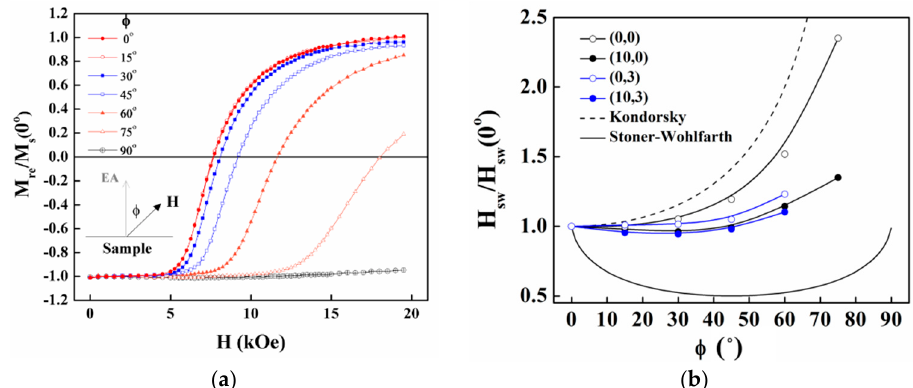
Figure 7. ( a ) A series of room temperature normalized ( M re / M s ) easy axis DCD curves of reference sample (0, 0) collected with the field and applied along different angles with respect to the sample easy axis; ( b ) Angular dependence of the normalized switching field ( H sw / H sw,0° ) as a function of the (BN, Ag, C) segregants and MoC inserted layer ; the curve of the reference sample (Ref) is also reported together with the theoretical curves corresponding to the Stoner-Wohlfarth and Kondorsky switching models.